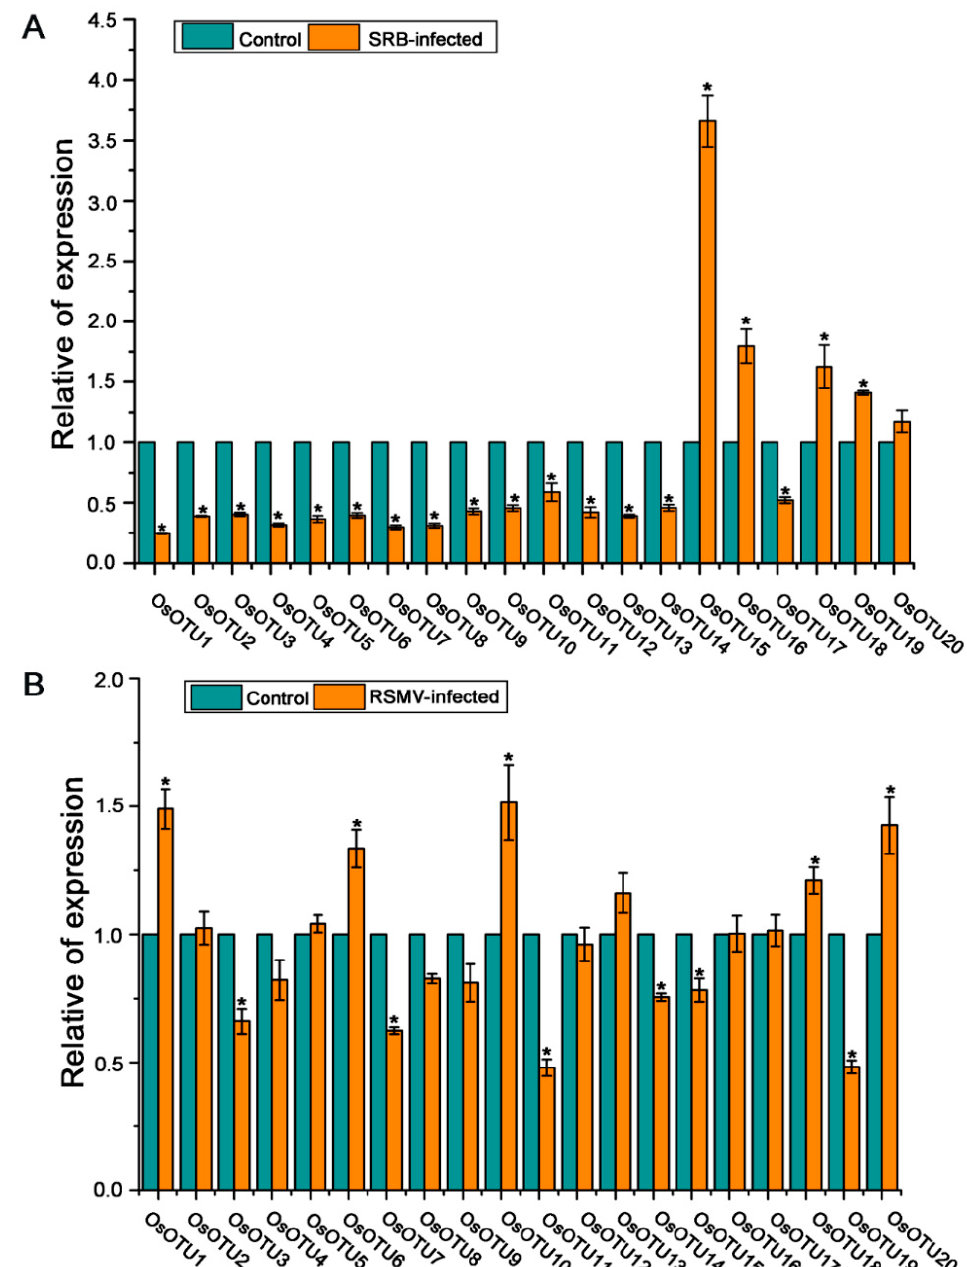
Figure 9. The expression of OsOTU genes in response to SRBSDV ( A ) and RSMV ( B ) infection. Three biological replicate experiments were performed for each treatment and gene expression was detected by RT-qPCR. Samples were collected at 40 dpi from RSV-infected plants and at 45 dpi from RSMV-infected plants. The OsUBQ5 gene was used to normalize the relative gene expression. Error bars represent ± SE ( n = 3). * indicates significant differences from the mock control at p ≤ 0.05 by Fisher’s least significant difference tests.